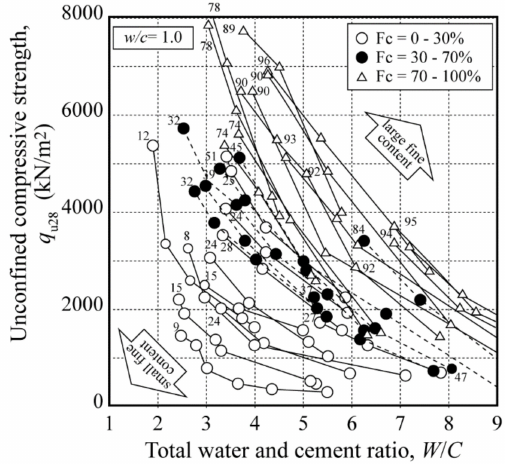
Figure 13. Relationship between the W/C ratio and unconfined compressive strength